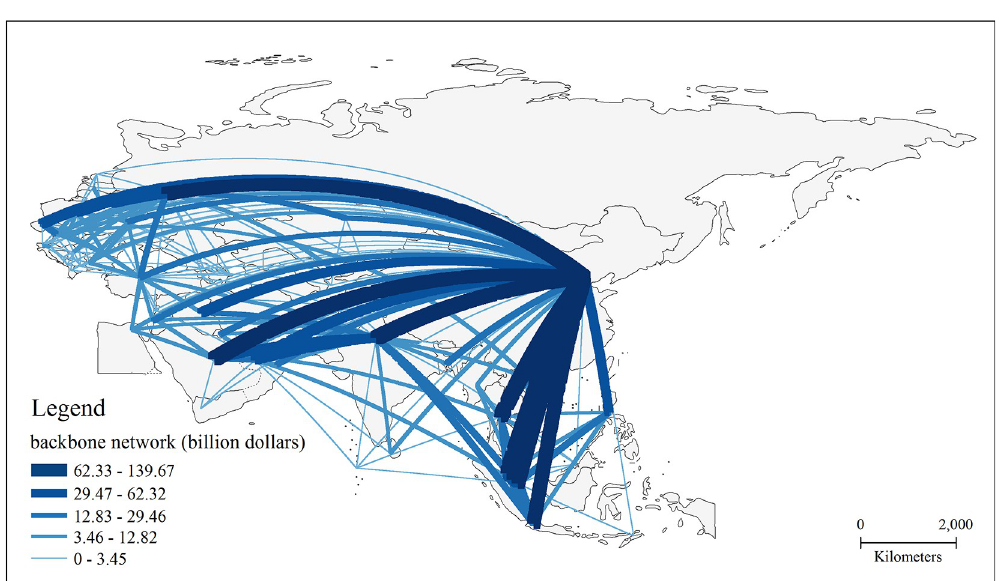
Fig 5. Backbone structure of the BRI trade network. Note: The basemap used to construct the map was obtained from the following source: China Map Publishing House Co., LTD. They have been republished under a CC BY license, with permission from the China Map Publishing House Co., original copyright